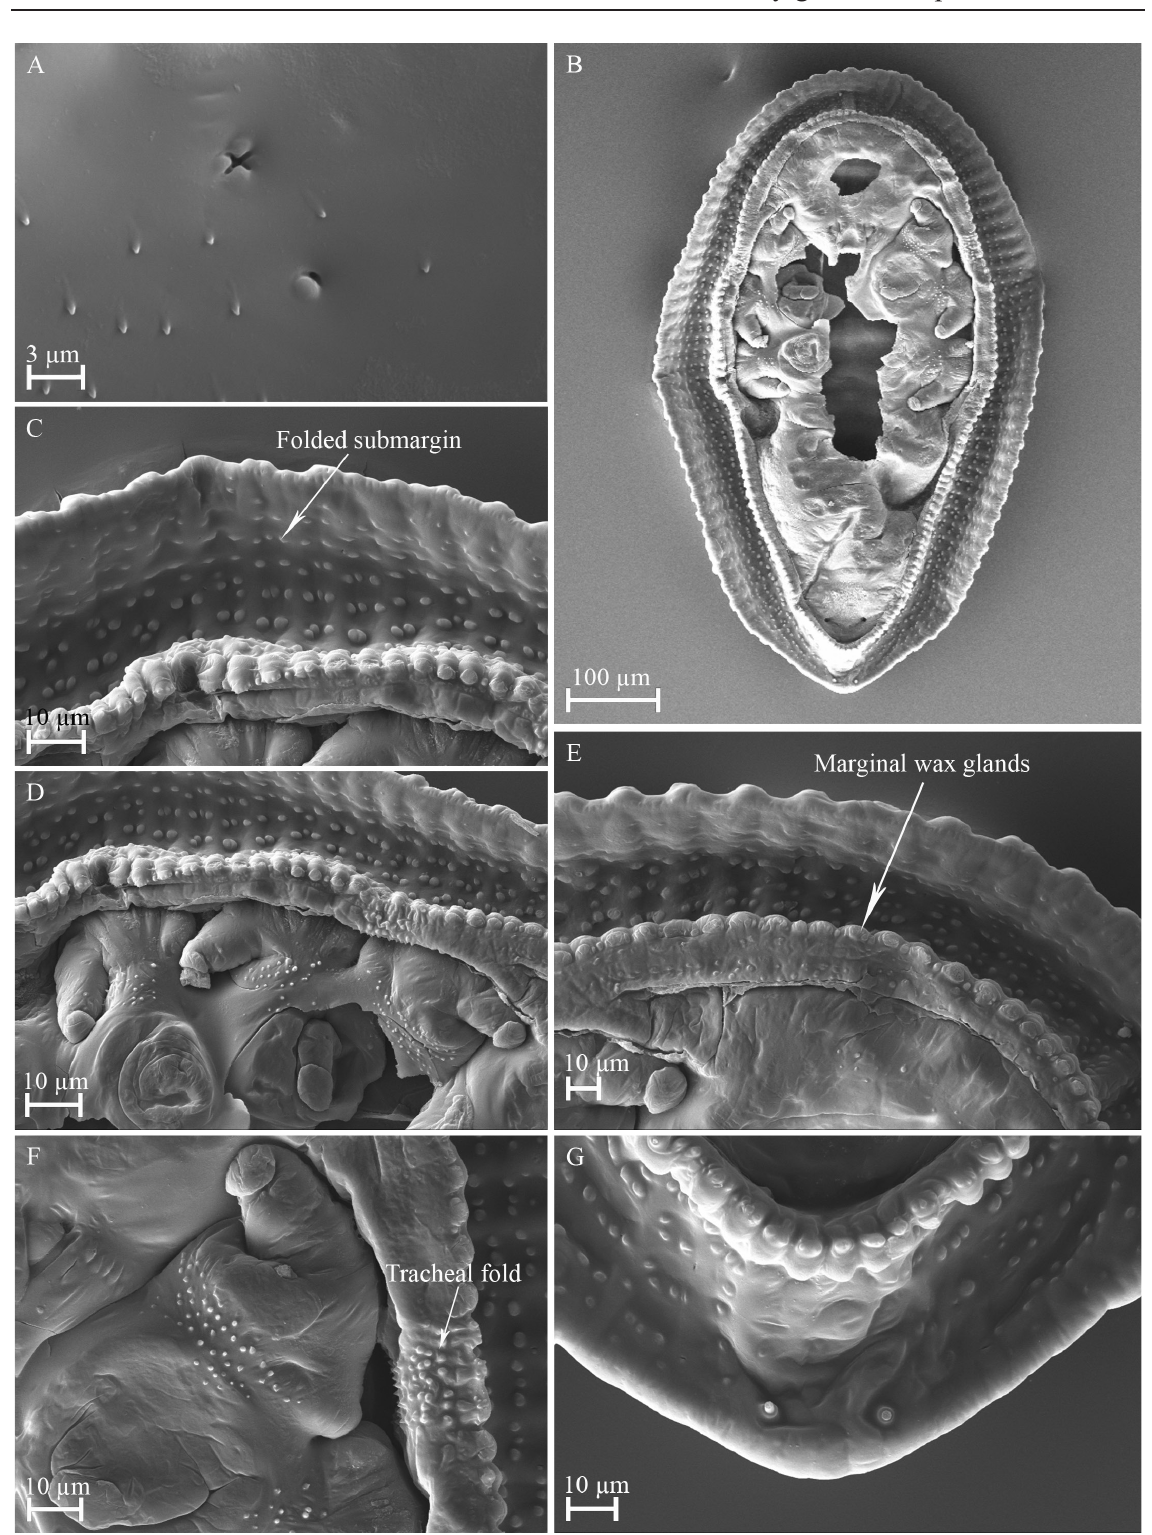
Fig. 9. Aleuropleurocelus ceanothi (Sampson, 1945), SEM microphotographs. B–G . Ventral views. A . Puparium, geminate pore. B . Ventral view. C . Ventrally folded submargin. D . Legs, stipples, spiracle. E . Marginal wax glands. F . Thoracic tracheal fold. G . Caudal tracheal pore and furrow